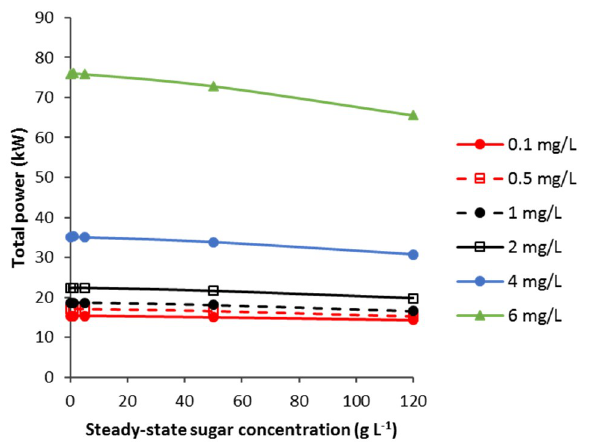
Figure 9. Effect of CSTB steady-state oxygen concentration on minimum total electrical power requirement. Each line is for a constant C OL value and each point represents the minimum total electrical power requirement at the specified steady-state sugar concentration.